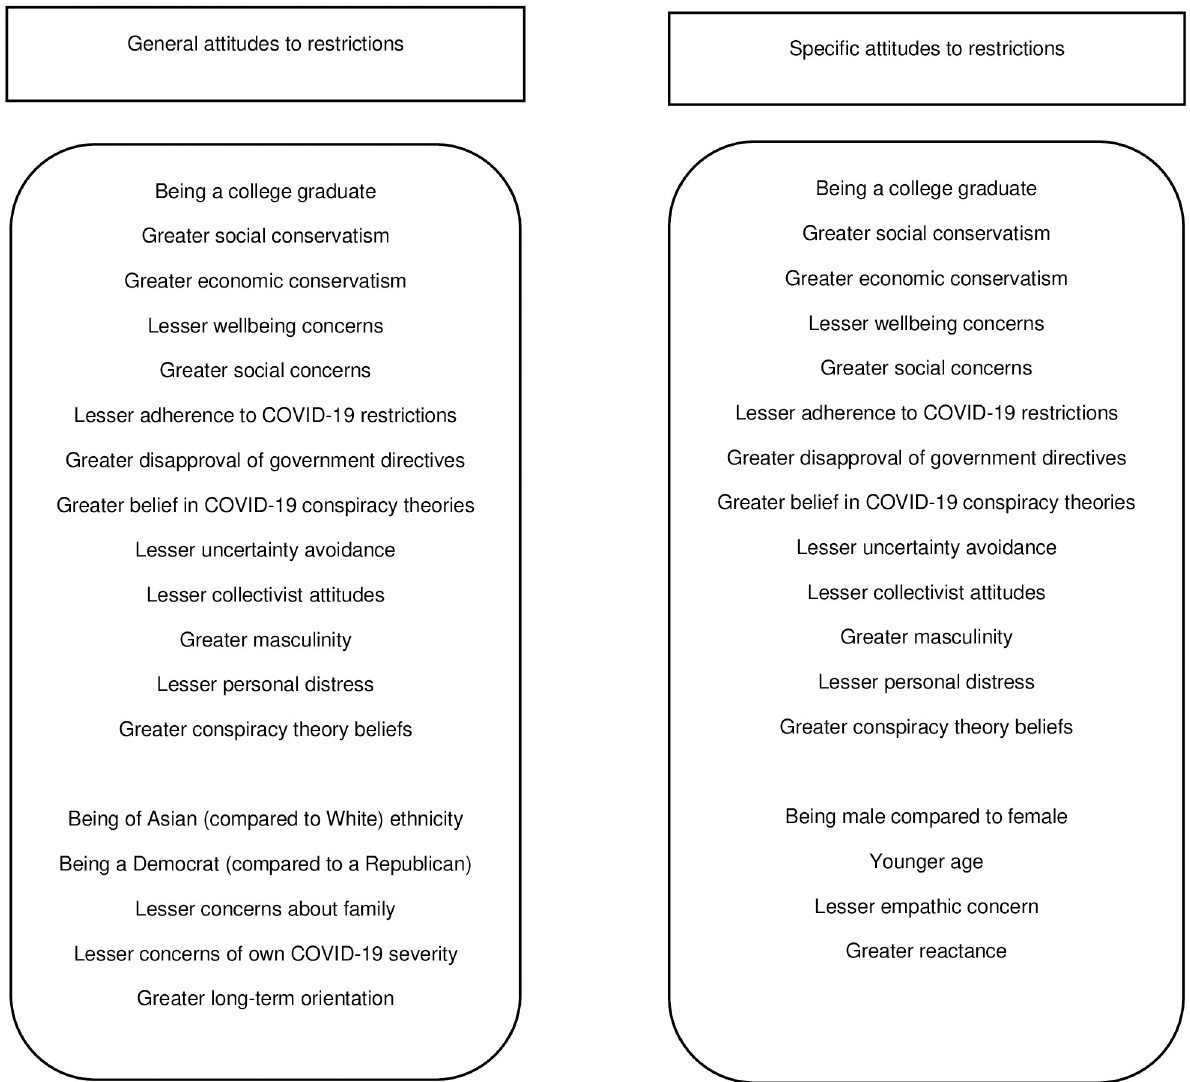
Fig 1. Significant predictors of greater support for easing COVID-19 restrictions for general and specific